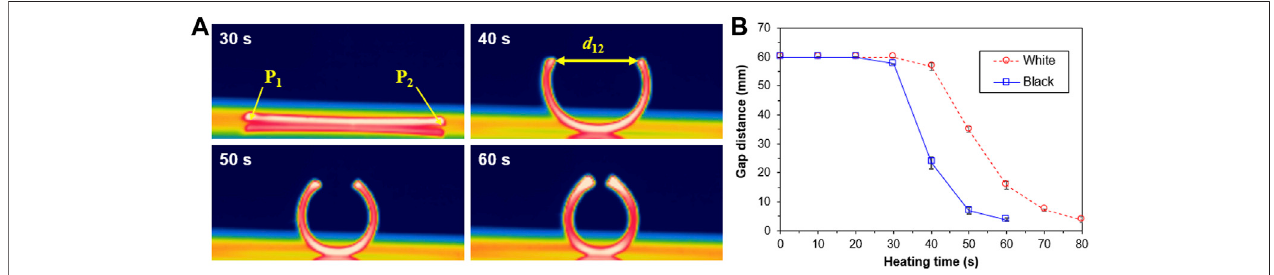
FIGURE5| Globalshapetransformationoftheblackrectangularbarspecimen (A) Deformationsandtherelevanttemperaturechanges (B) Comparisonofthegap distances of the black and white specimens.